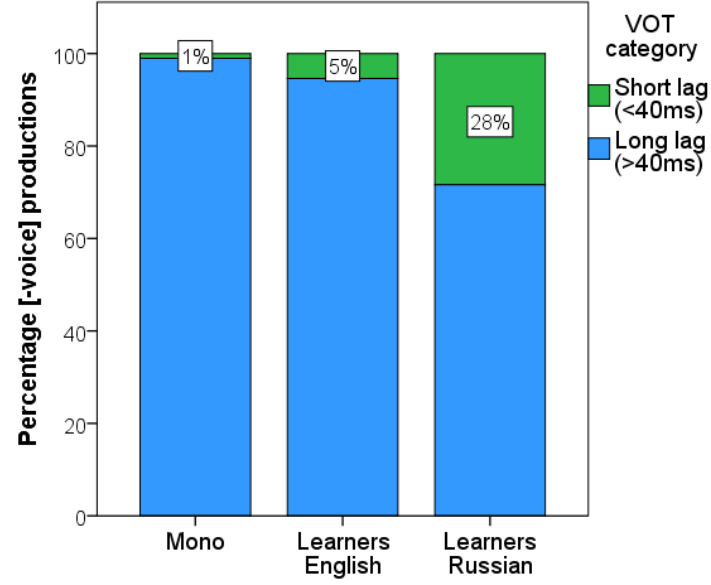
Figure 7. Percentage of short lag productions among [ − voice] stops in monolingual controls’ and learners’ English; learners’ Russian is provided for comparison.